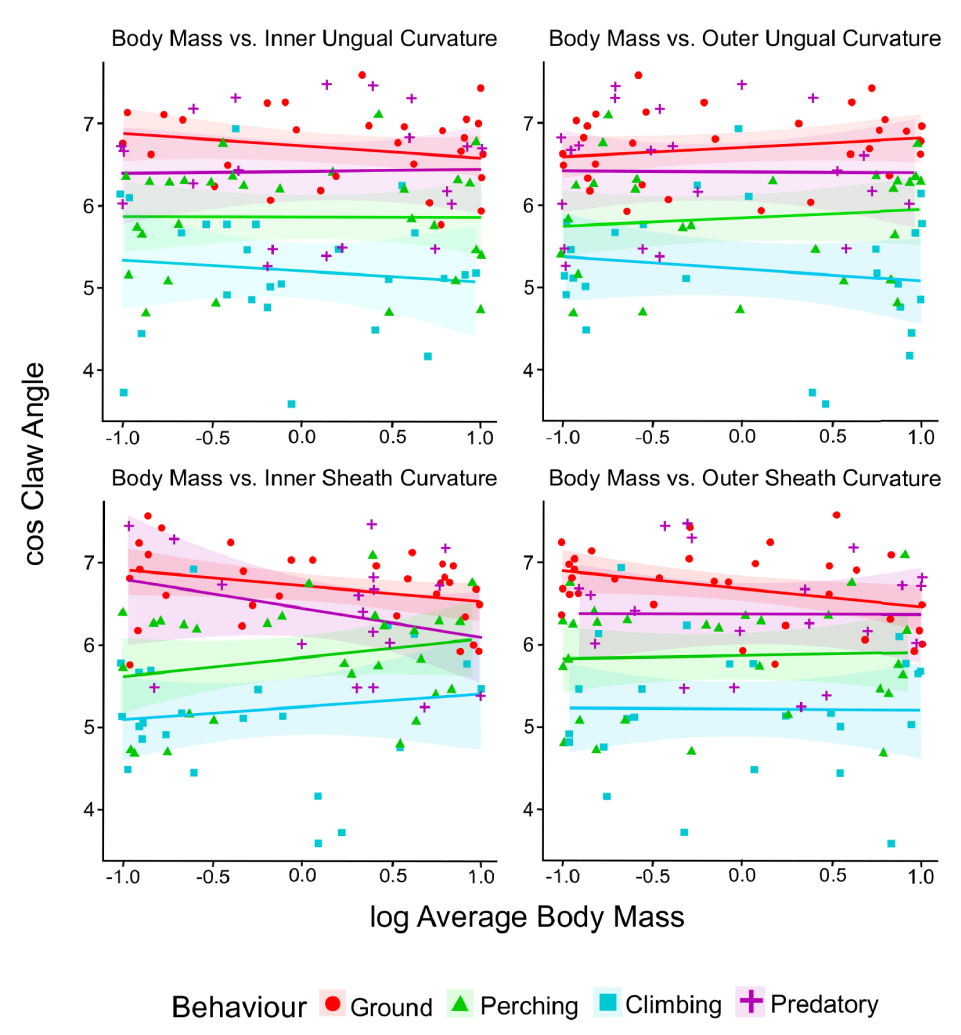
Fig 3. Regression plots for claw angle against body mass grouped by behavioural category. The shaded area represents 95% confidence limits of the regressions. Only one of the regressions is statistically significant.